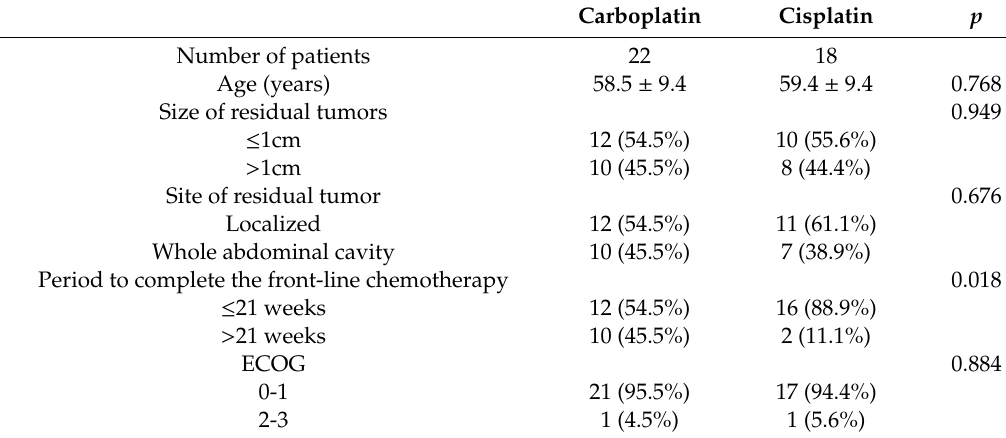
Table 1. Characteristics of the patients with FIGO IIIC serous type epithelial tubo-ovarian cancer, or primary peritoneal carcinoma treated with weekly paclitaxel (80 mg / m 2 ) plus either carboplatin